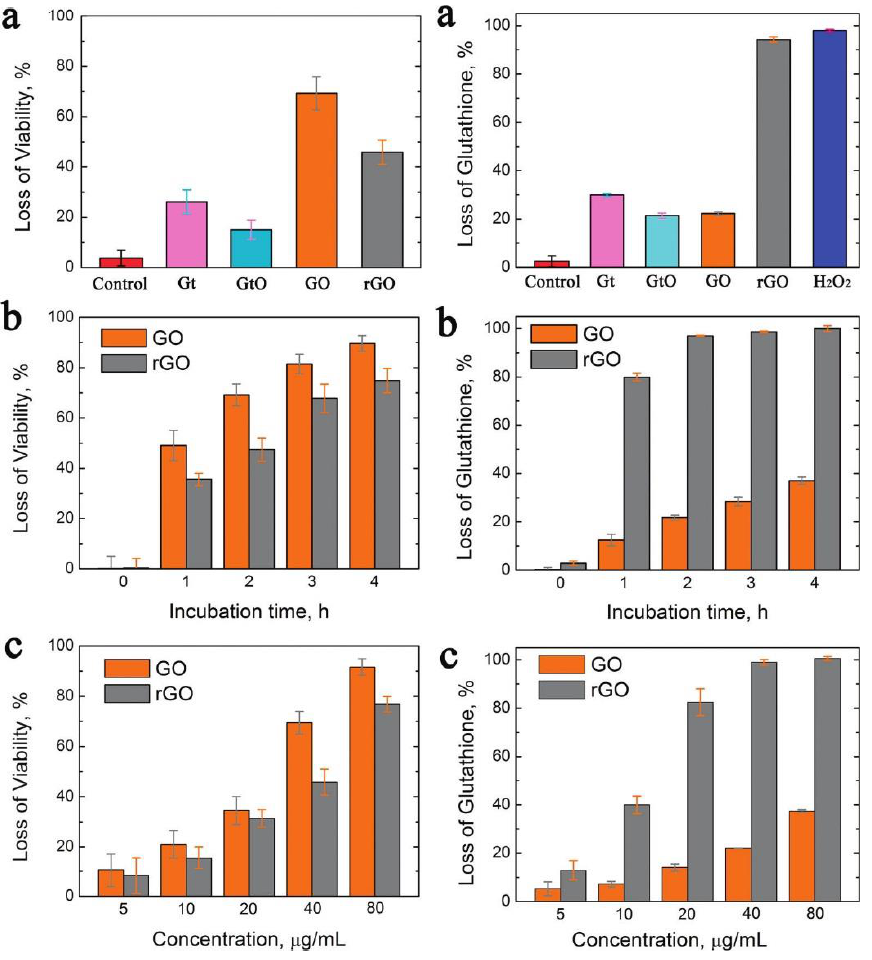
Figure 2. Left: ( a ) Viability of E. coli after incubation with Gt (graphite), GtO, GO, and rGO dispersions; ( b ) time-dependent antibacterial activities of GO and rGO with E. coli ; and ( c ) concentration-dependent antibacterial activities of GO and rGO, E. coli was incubated for 2 h. Right: Oxidation of glutathione by graphene-based materials: ( a ) loss of GSH (0.4 mM) after in vitro incubation with Gt, GtO, GO, and rGO dispersions for 2 h; ( b ) time dependent GSH (0.4 mM) oxidation by GO and rGO dispersions (40 μg/mL) after incubation from 0 to 4 h; and ( c ) concentration dependent GSH (0.4 mM) oxidation by GO and rGO after incubation for 2 h. Obtained from [34], with permission from the American Chemical Society 2011.